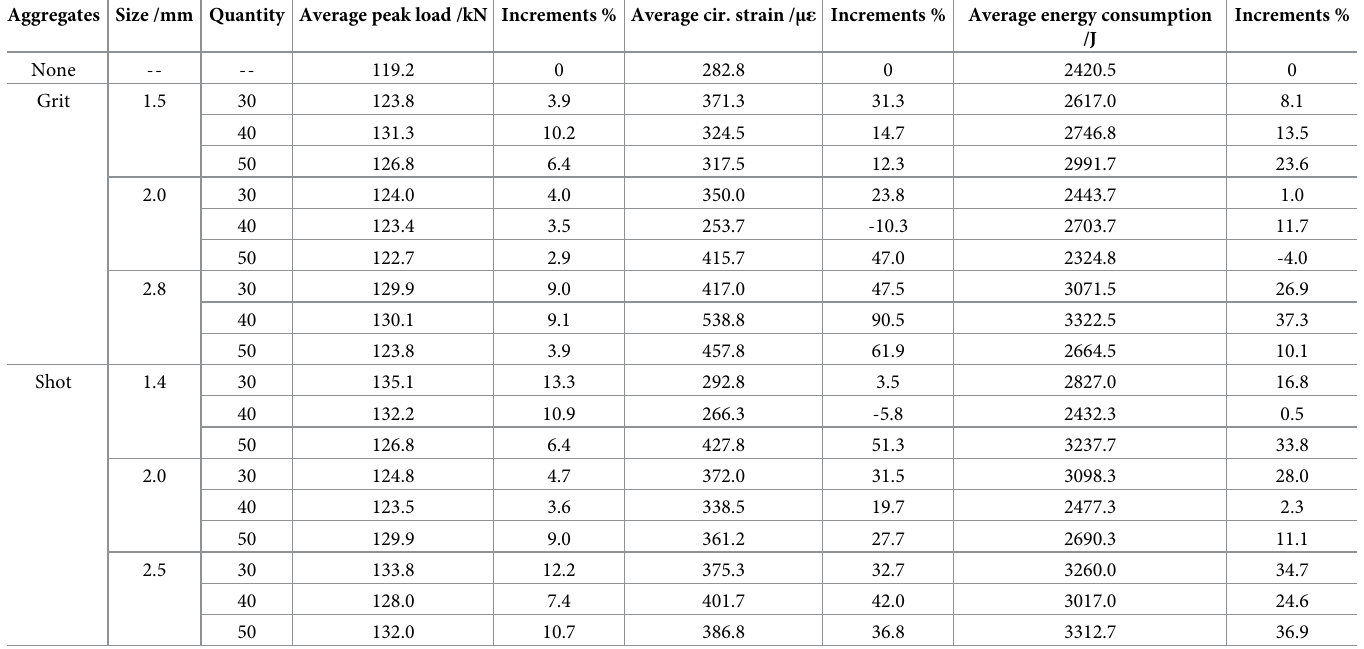
Figs 21–23 show the effects of two aggregate shapes on anchoring force, circumferential strain and energy consumption, ignoring the quantity but considering the size of aggregates. The Table 3. Testing results of the pullout